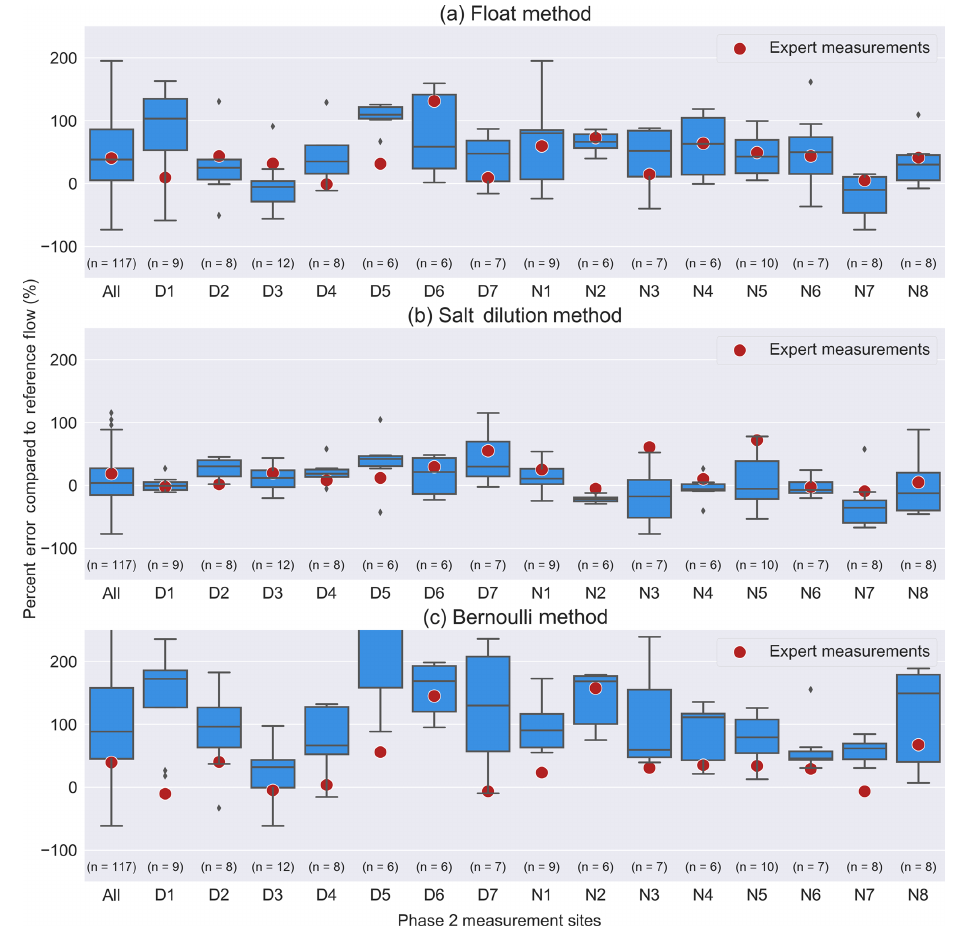
Figure 4. Box plots showing distribution of CS Flow group percent errors compared to reference flows for (a) float, (b) salt dilution, and (c) Bernoulli streamflow measurement methods. A summary of “all” measurements followed by the 15 phase 2 measurement sites (i.e., D1 to D7 in the Dhobi watershed and N1 to N8 in the Nakkhu watershed) is shown on the horizontal axes. Percent errors for expert measurements for each site and method are shown as red circles. The expert measurements shown for “all” are the mean of all expert measurements for each method. Sample sizes for each method and each site are shown in parentheses above each site label. Boxes show the interquartile range between the first and third quartiles of the dataset, while whiskers extend to show minimum and maximum values of the distribution, except for points that are determined to be outliers (shown as diamonds), which are more than 1.5 times the interquartile range away from the first or third quartiles. To facilitate comparison between sub-panels, vertical axes are fixed from − 150% to 250%. In certain cases, portions of the error distribution are outside of the fixed range (e.g., site D5 for the Bernoulli method, c ). Table 3. Summary of phase 2 survey questions and the meanings of ranks. No. Question Rank 1 Rank 3 meaning meaning Q1 Required training for each method